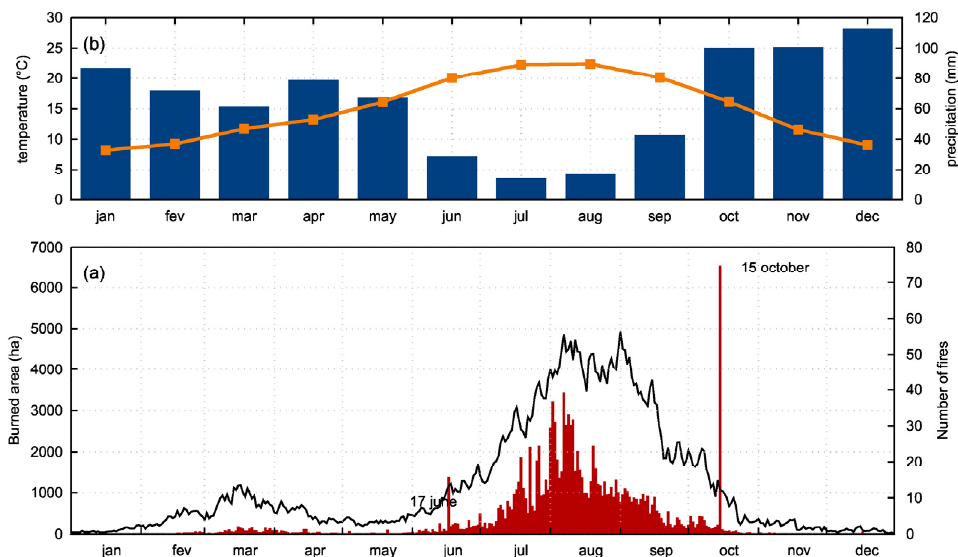
Figure 2. ( a ) Daily mean values of the number of fires (black solid line) and burned area (red vertical lines) in the period of 1980–2018. The peaks on 17 June and 15 October are mainly due to the exceptional contribution of 2017. ( b ) Monthly average values of air temperature (orange line) and total precipitation (blue columns) over mainland Portugal (163 grid points) based on 30 years of ERA5 reanalysis (1981–2010). For details on data, see Section 2.